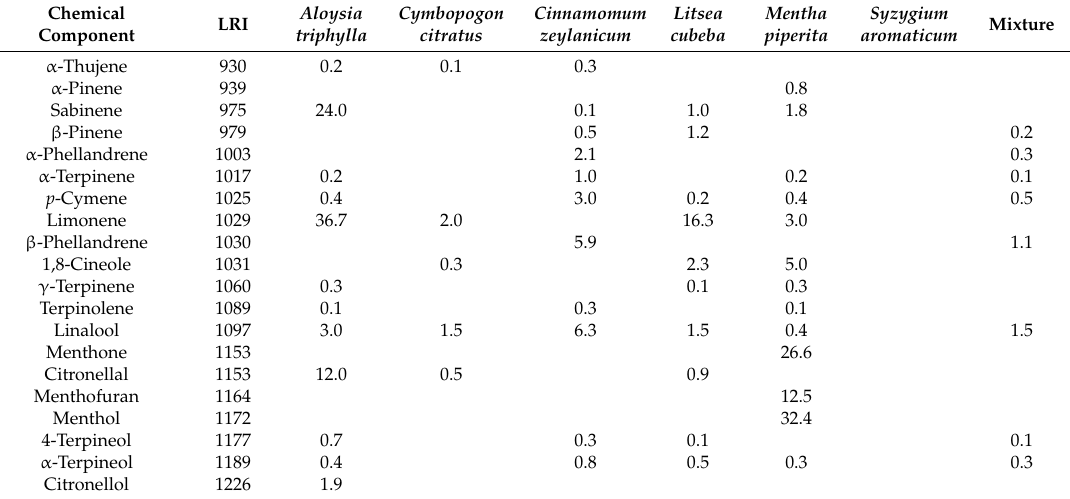
Table 1. Chemical composition of the essential oils (EOs) tested, expressed as percentage. Chemical